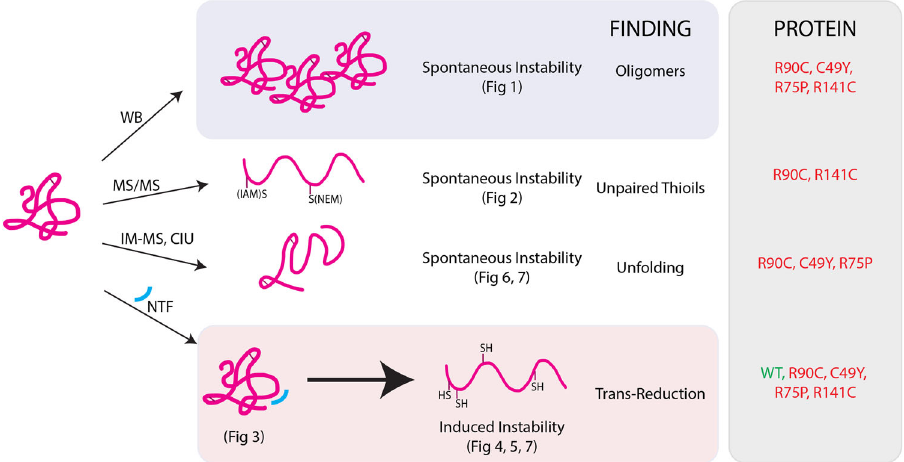
Fig. 8 Summary of fi ndings and conclusions. Overall, most mutants demonstrated increased spontaneous instability compared to WT protein, but not all mutants revealed increased instability in all assays tested. Of the assessments of spontaneous instability, multimerization ( fi rst row) was observed for all mutants tested. The number of reduced thiols and dynamic instability differed among mutants (second and third rows). The addition of NTF (light blue arc in red box; fourth row), however, induced all mutant proteins into an even less stable state by multiple measures: increased free cysteine labeling visualized by SDS-PAGE gels and MS/MS, increased presence of degradation products identi fi ed by IM-MS, and decreased energy requirements for protein unfolding observed by CIU. NTF also altered WT protein but to a lesser degree compared to mutant